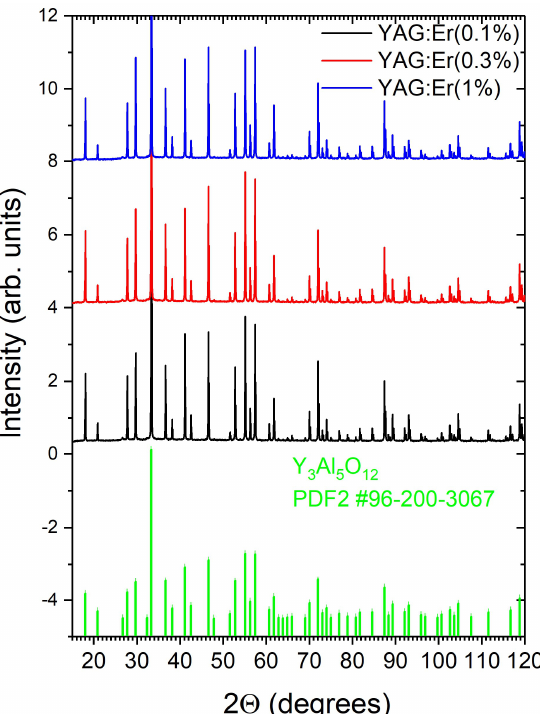
Figure 1. XRD patterns of the YAG:Er (0.1, 0.3 and 1%) samples (indicated in the legend). The PDF2 record #96-200-3067 is also shown.